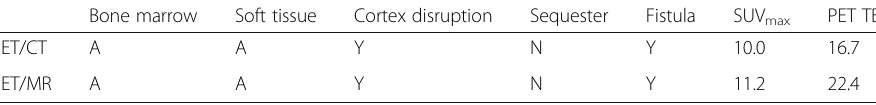
Table 3 Consensus results for patient 3 Bone marrow